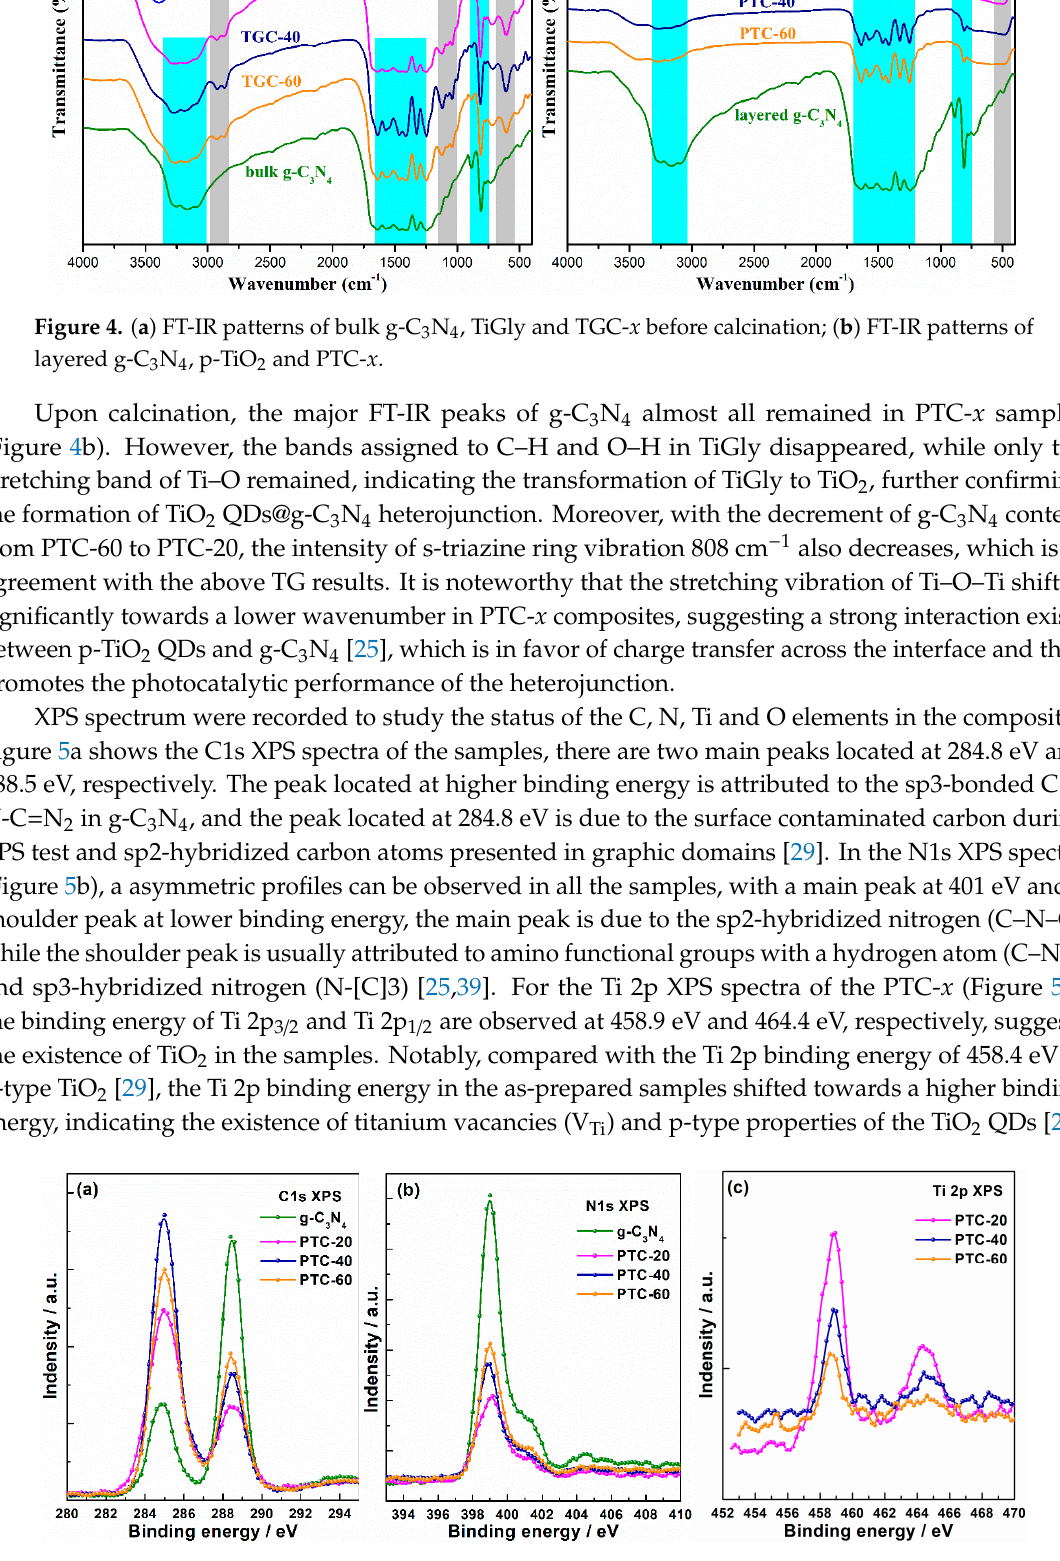
Figure 5. ( a ) C1s, ( b ) N1s and ( c ) Ti 2p XPS spectra of layered g-C 3 N 4 , p-TiO 2 and PTC- x ,